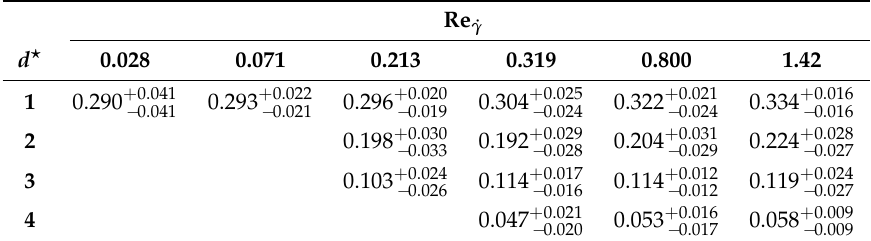
Table 1. Collision efficiency for various combinations of shear Reynolds numbers and particle size